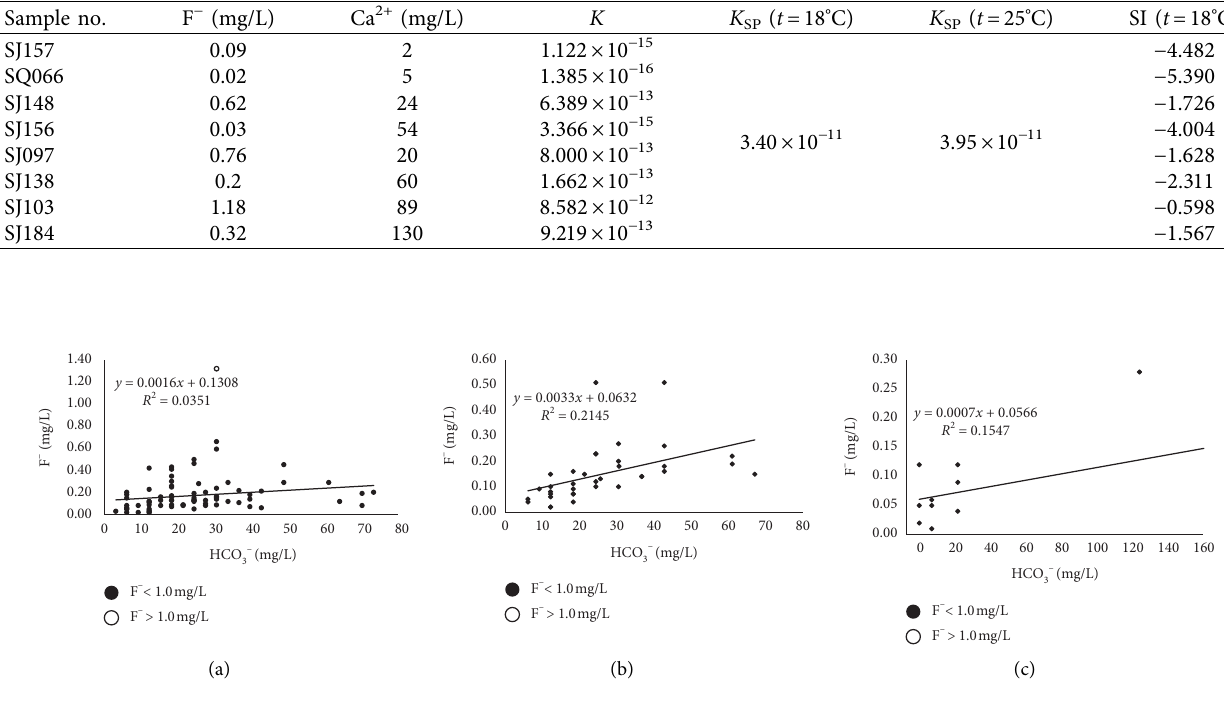
Figure 7: Relationship between F − and HCO − in groundwater of different subsystems. (a) Groundwater subsystem of Suishui River. (b) 3 Groundwater subsystem of Jianshui River. (c) Groundwater subsystem of Wushu